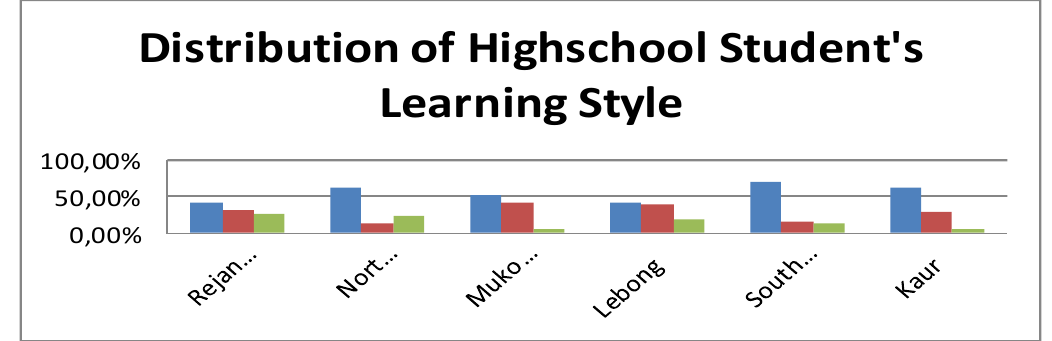
Figure 3 : The Distribution of Senior High-school’s Learning